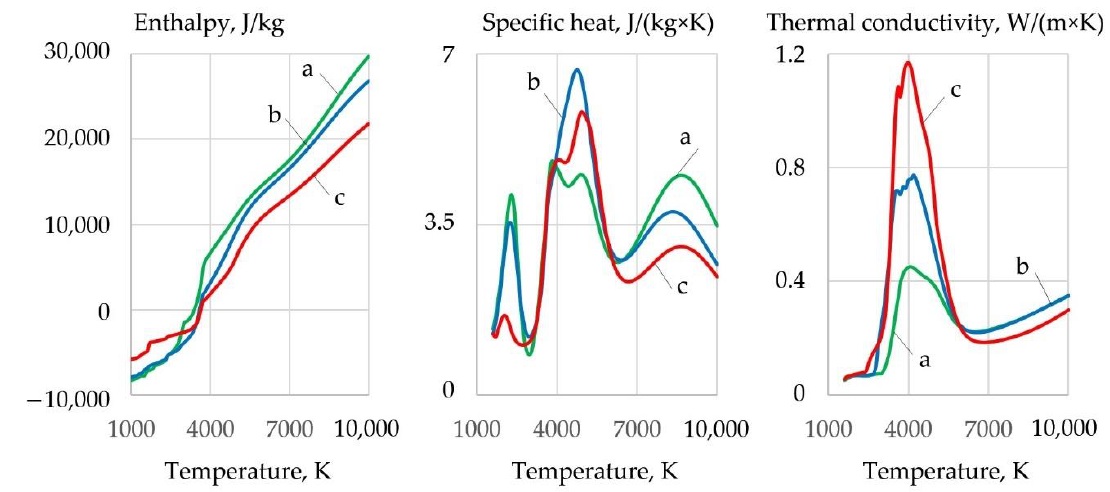
Figure 14. Thermophysical properties of the system, wt.%: ( a ) 60Fe 3 O 4 + 20Al + 20Na 3 AlF 6 ; ( b ) 60MoO 2 + 20Al + 20Na 3 AlF 6 ; ( c ) 60WO 2 + 20Al + 20Na 3 AlF 6.